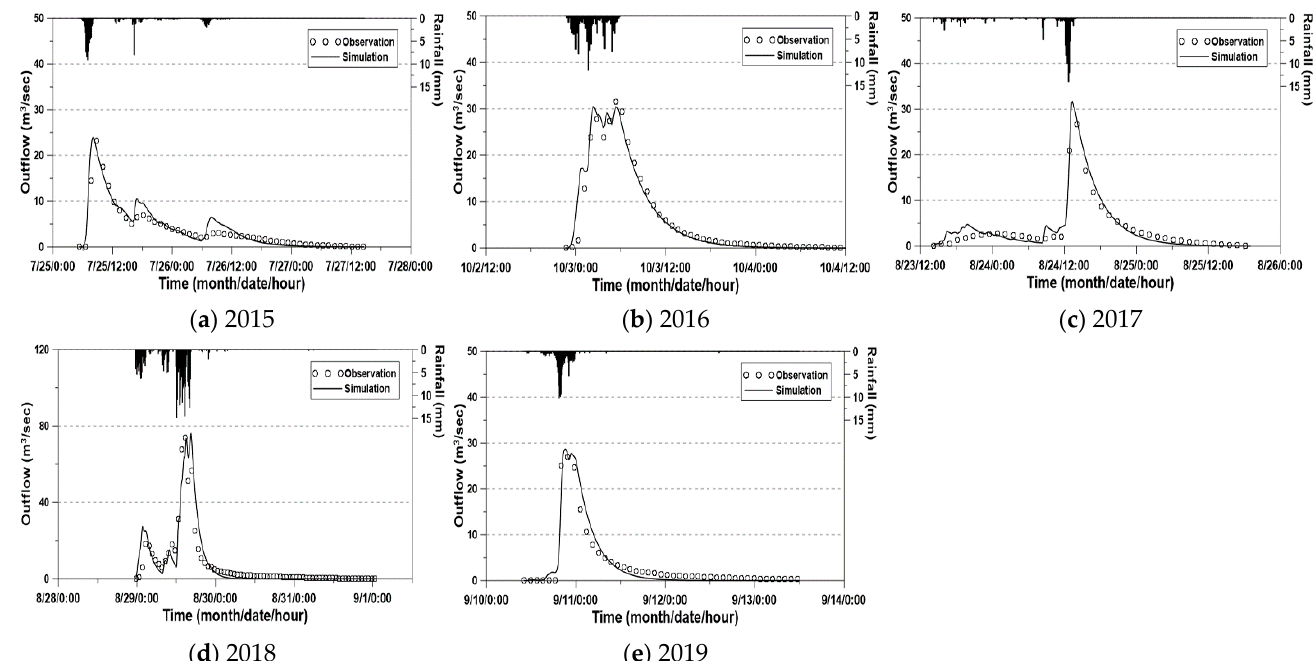
Figure 5. Comparison of the observed and simulated runoff hydrographs derived based on analytically-derived Clark IUH with the same channel and hillslope velocity for the events occurred in 2015 ( a ); 2016 ( b ); 2017 ( c ); 2018 ( d ); and 2019 ( e ).